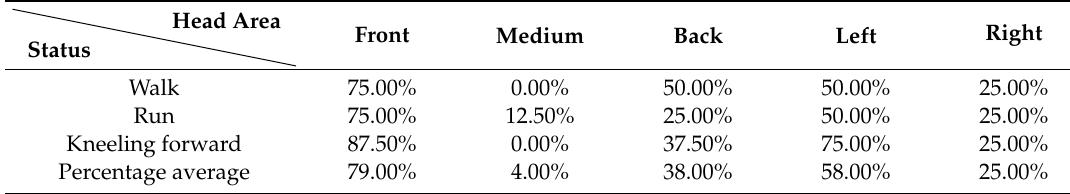
Table 4. Display from the host computer for the pressure peak